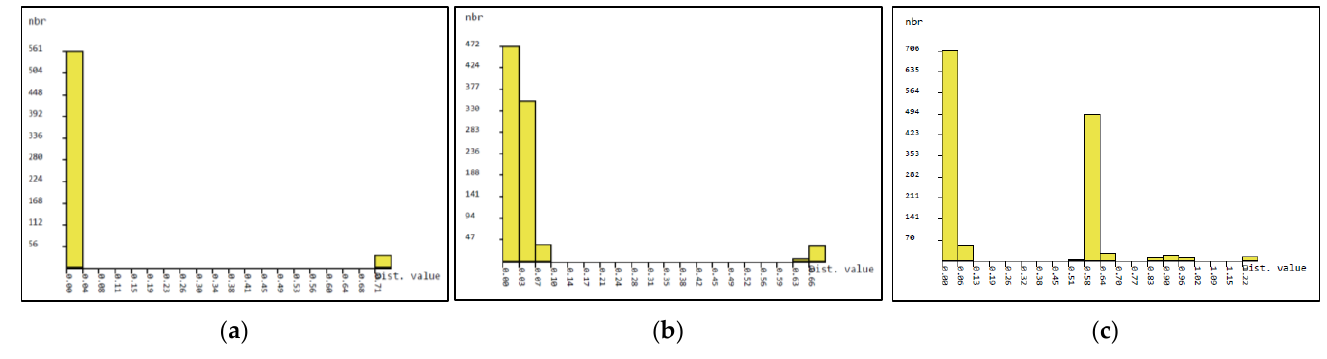
Figure 4. Barcode gap analysis of N. gracilis , N. ampullaria , and N. rafflesiana generated by Automatic Barcode Discovery Gap Discovery (https://bioinfo.mnhn.fr/abi/public/abgd/abgdweb.html, ac- cessed on 23 January 2023) [25] for ( a ) rbcL, ( b ) ITS2 and ( c ) ITS1. Distributions of K2P distances and between each pair of specimens for the histogram of distance.